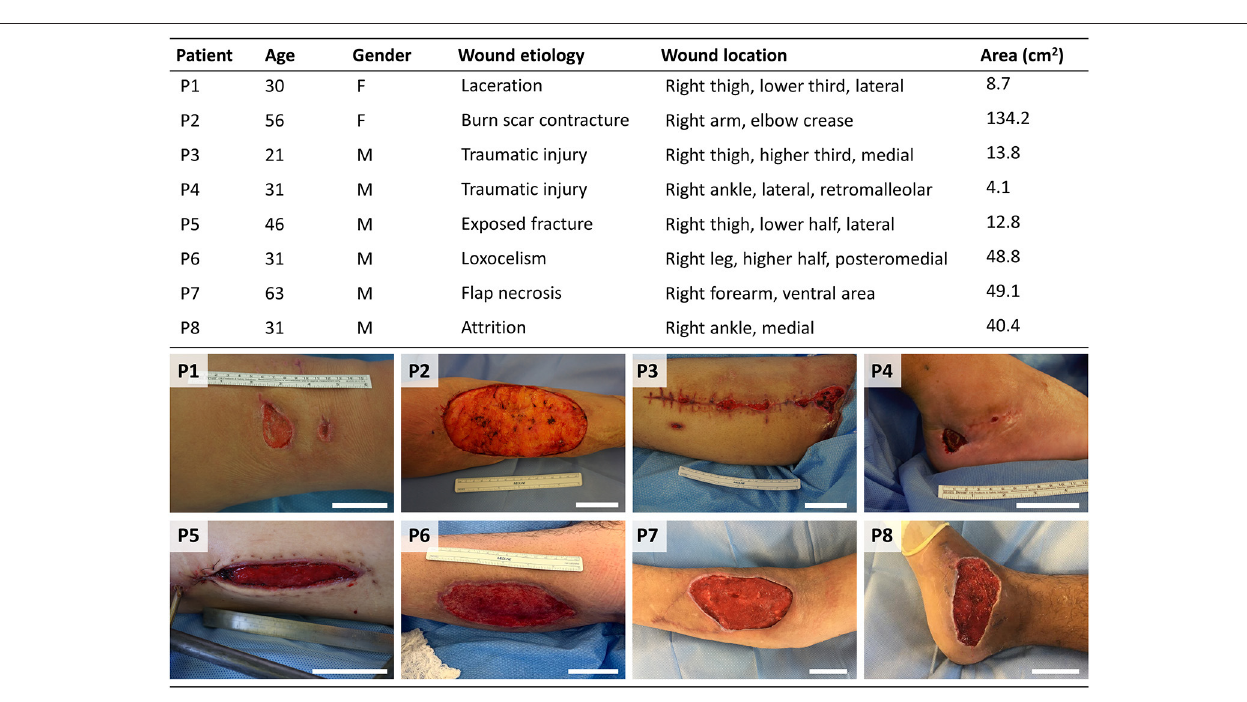
FIGURE 3 | Characteristics of the enrolled patients. Table (top) showing characteristics of patients treated with the photosynthetic scaffold: patient’s age (years), gender (Female/Male), etiology, location, and area of the wound. Images (bottom) show patient’s full skin wounds at the moment of surgery, prior to photosynthetic scaffold implantation. Scale bars represent